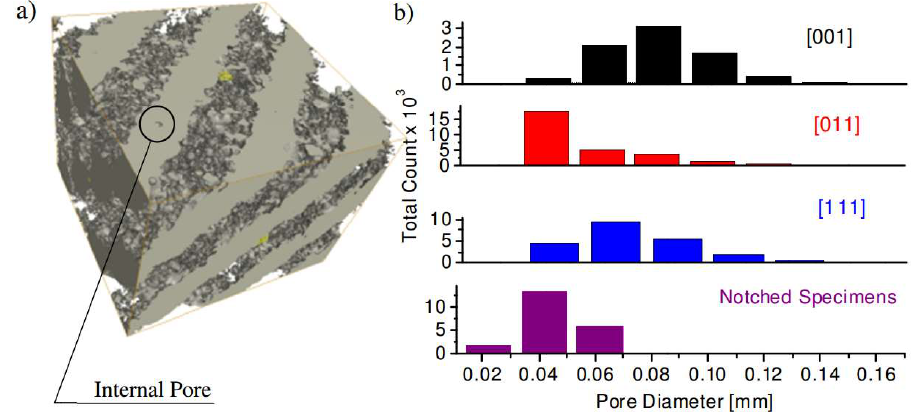
Figure 5. Internal porosity analysis of the lattice and dense notched specimens: ( a ) example of an internal pore found in the material; ( b ) pore distribution histogram for the lattice and dense specimens.